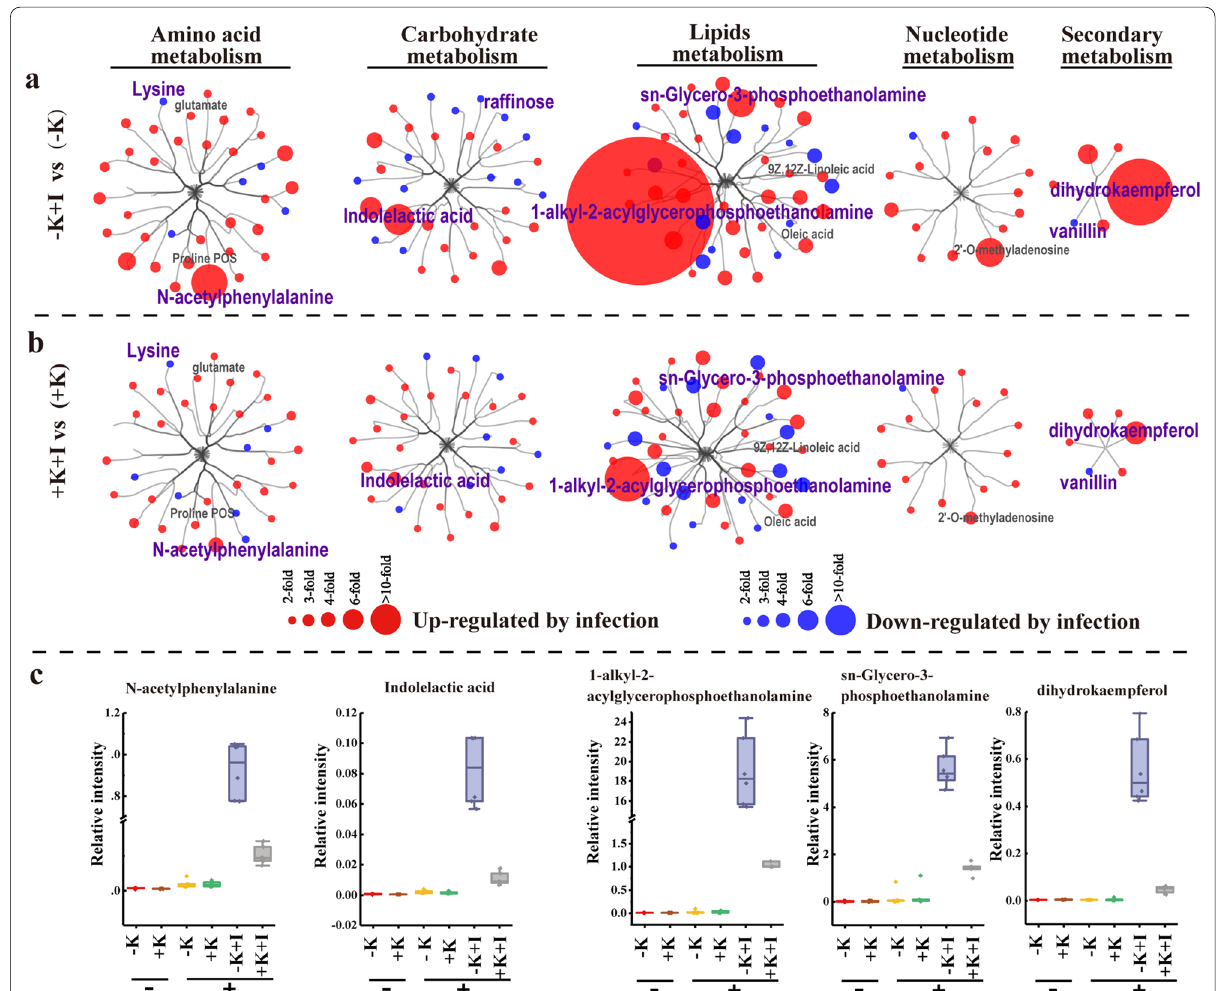
Fig. 3 Survey of metabolic processes indicates that lipid metabolism is severely affected by S. oryzae infection. a Effects of S. oryzae infection on the metabolic profile of K-starved plants (at 5 days after inoculation). The metabolites were clustered using Cytoscape and the sizes of the circles denote the FC values (n 6 biological replicates). b Effects of S. oryzae infection on the metabolic profile of K-sufficient plants. Blue indicates higher = FC values for uninfected plants, and red denotes higher FC values for diseased plants; the treatments in brackets were performed as controls. c Examples of compounds substantially altered by S. oryzae infection. The center line in each box plot represents the mean relative intensity (n